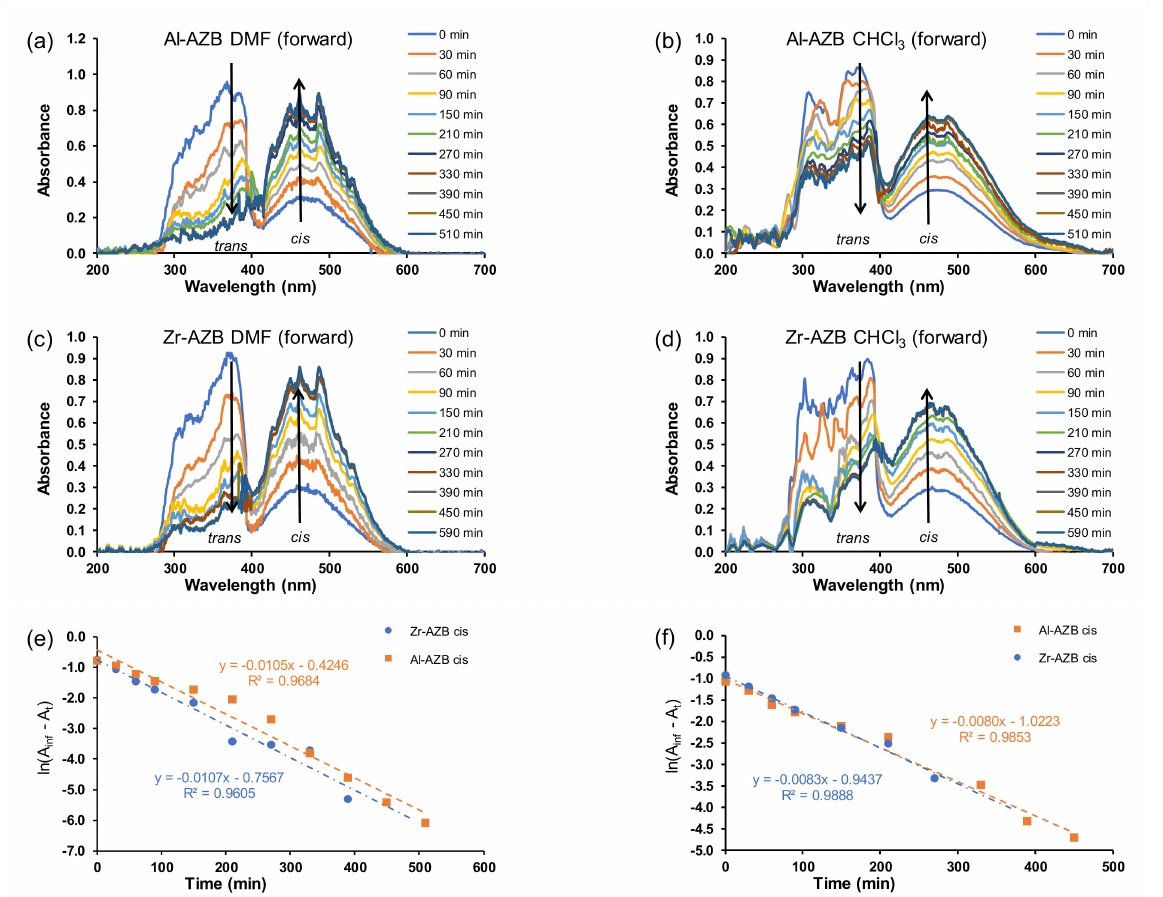
Figure 4. Plot of absorbance vs. wavelength for the forward ( trans–cis ) isomerisation in DMF (50 ppm) for ( a ) Al-AZB and ( c ) Zr-AZB. Plot of absorbance vs. wavelength in CHCl 3 (50 ppm) for ( b ) Al-AZB and ( d ) Zr-AZB. Plot of ln(A inf - A t ) vs. time for Al-AZB and Zr-AZB in ( e ) DMF and ( f ) CHCl 3